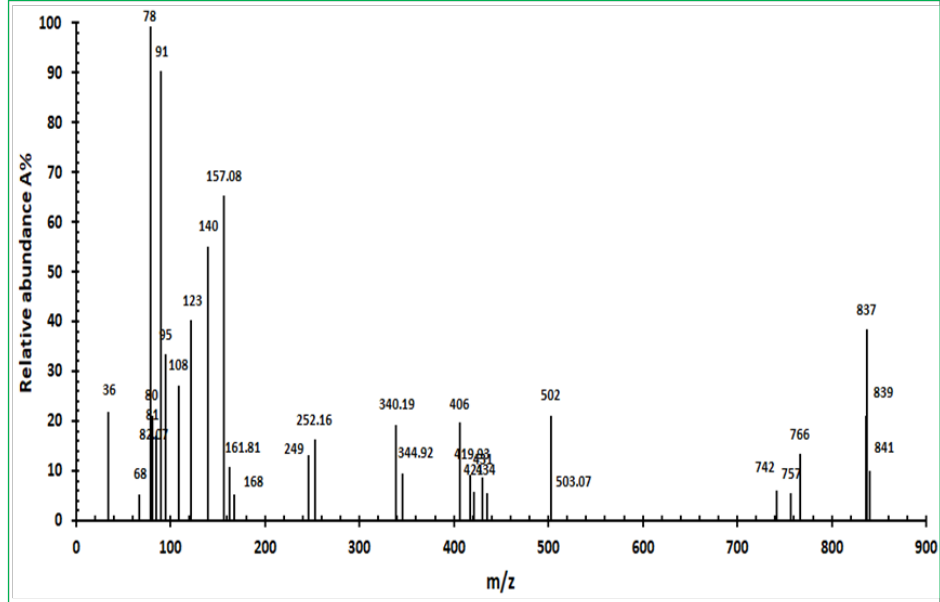
Figure 6. GC-Mass analysis of HNAP/QA.